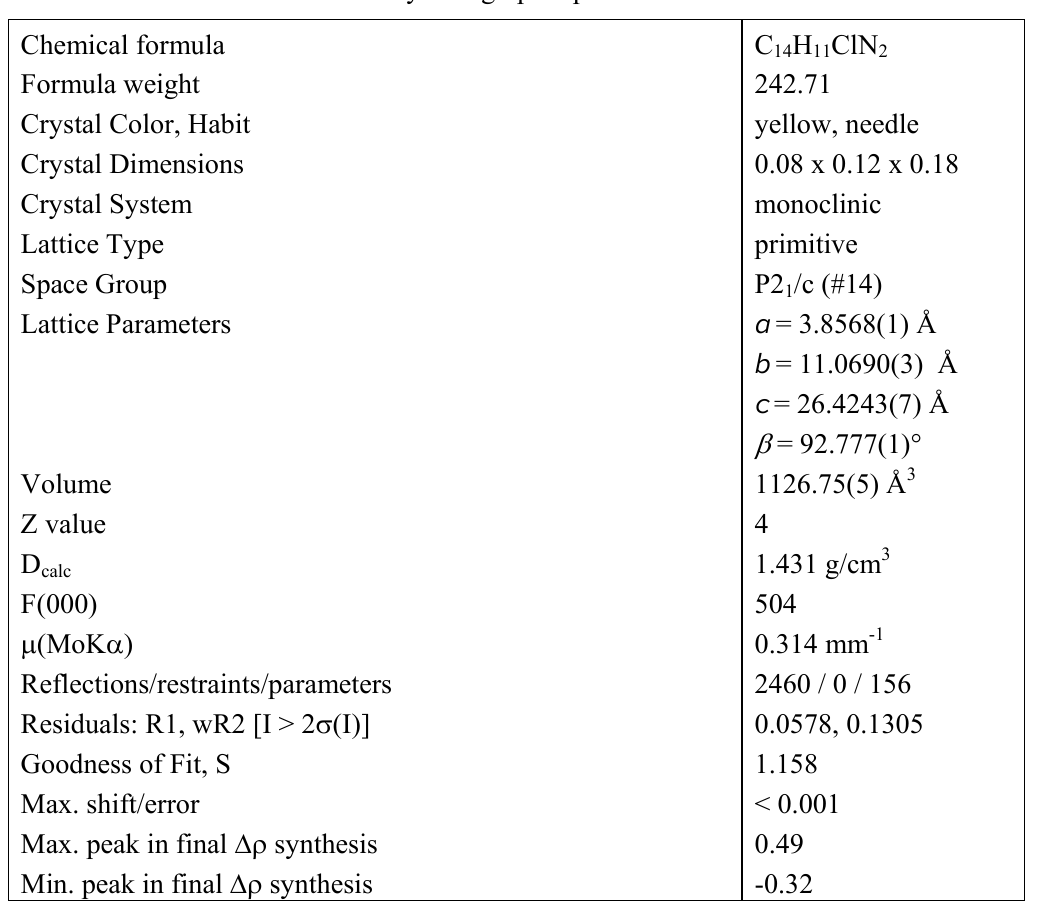
Table 1. Crystallographic parameters for